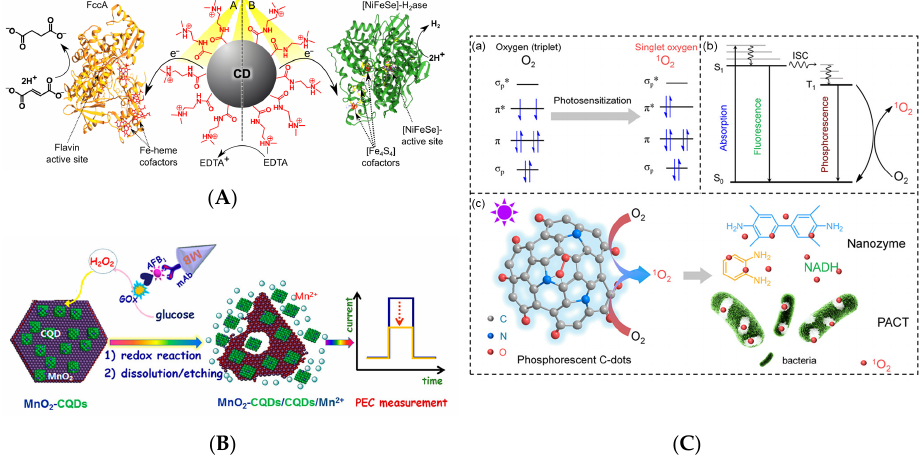
Figure 10. ( A ) Light-driven photocatalytic hydrogenation of fumarate to succinate and hydrogen